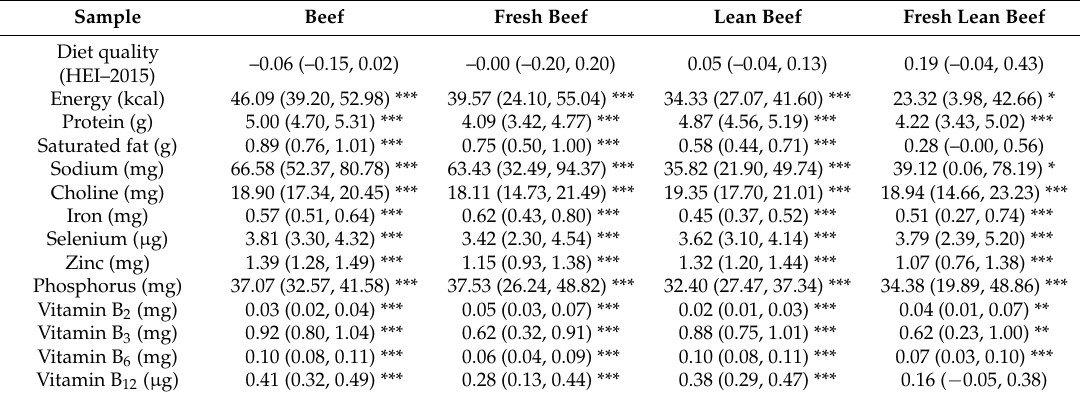
Table 3. Estimated effects of beef, fresh beef, lean beef, and fresh lean beef consumption on daily energy/nutrient intake and diet quality among U.S. adults, 2005–2016